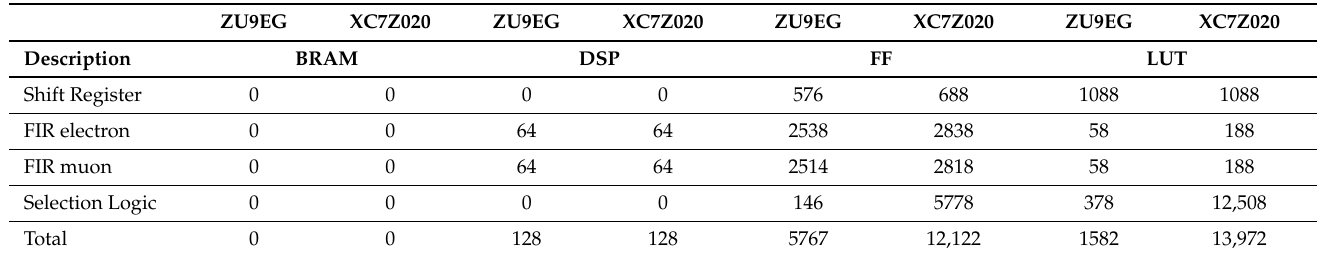
Table 3. Resource utilization of the FIR-based correlation pulse